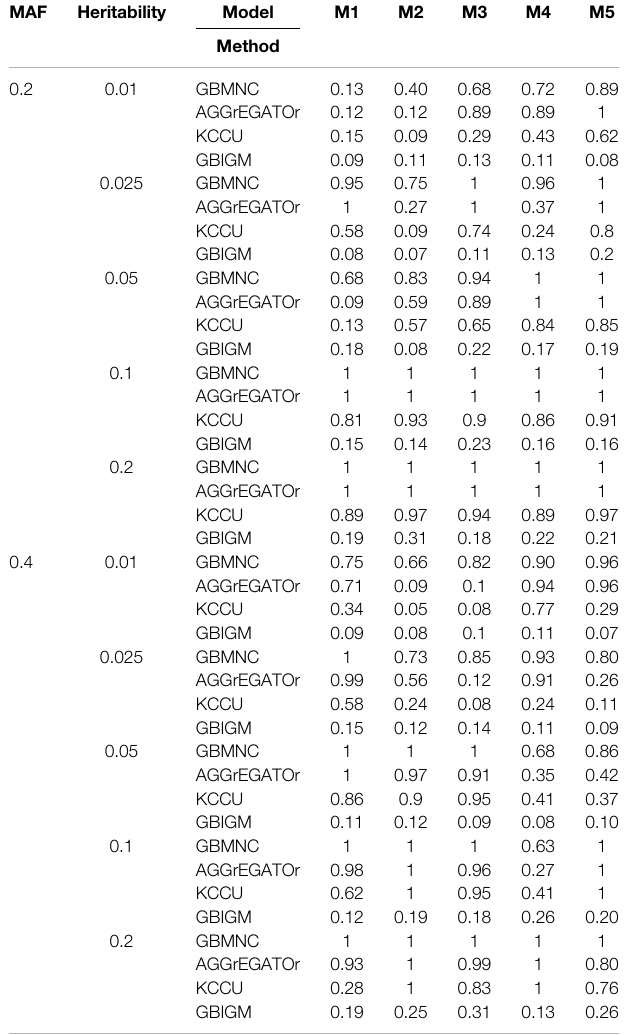
TABLE 3 | The statistical power of simulation studies for GBMNC, AGGrEGATOr, KCCU and GBIGM under 10 heritability-MAF combinations, with h ∈ { 0 . 01 , 0 . 025 , 0 . 05 , 0 . 1 , 0 . 2 } and MAF ∈ { 0 . 2 , 0 . 4 } . Each heritability-MAF combination has fi ve models. Bold font indicates the method that performed best under each model.